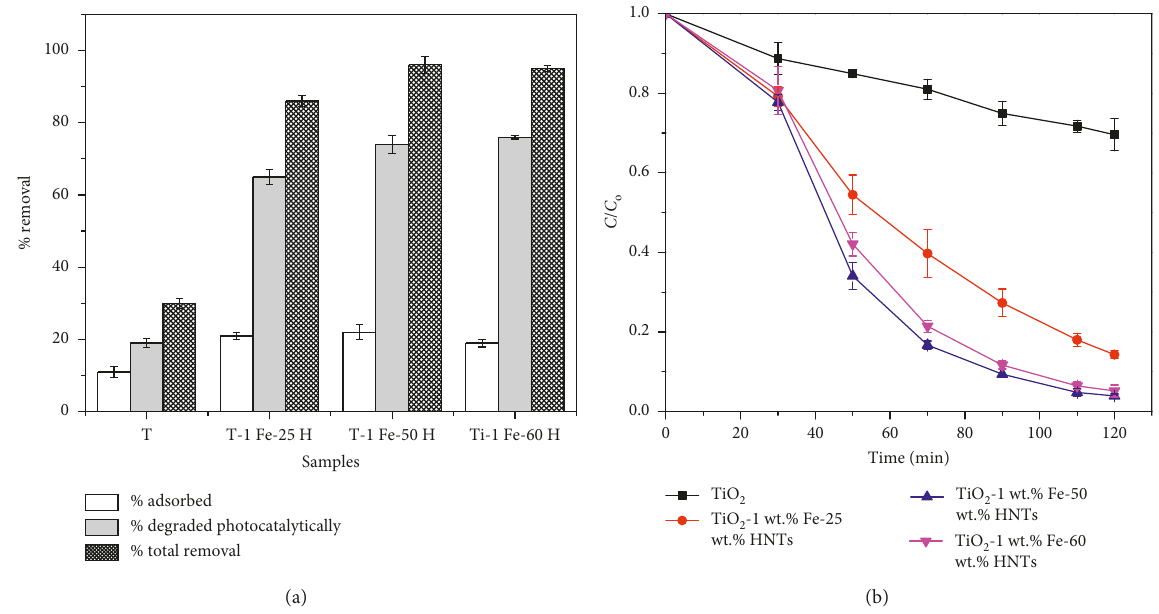
Figure 2: (a) Photocatalytic degradation and adsorption of rhodamine blue by TiO the synthesized TiO 2 and TiO 2 -Fe-HNTs (T: TiO 2 ; T-Fe-H: TiO 2 -Fe-HNT